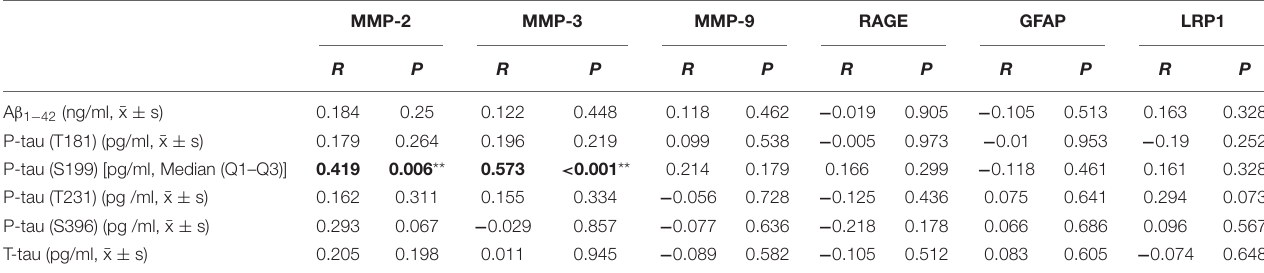
TABLE 8 | Correlations of levels of neuropathological biomarkers of AD with the levels of BBB factors in CSF from AD-HL